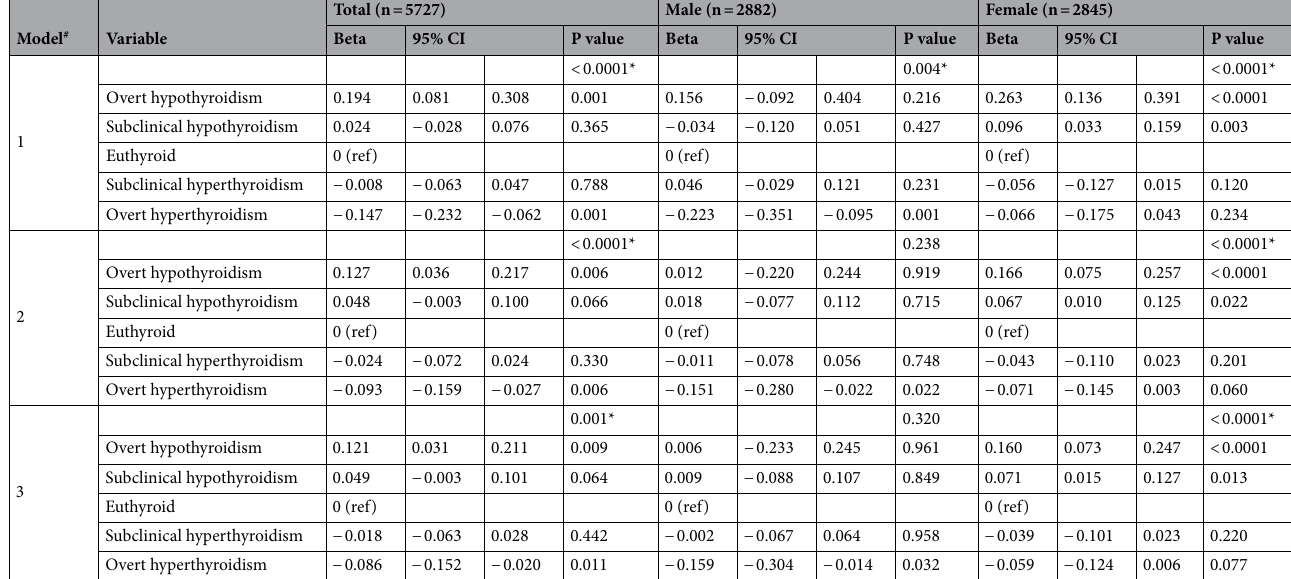
Table 3. Association between categorical thyroid function and TyG index. # Model 1: linear regression analysis, 2: multiple regression analysis after adjustment for age, sex, systolic blood pressure, BMI, alcohol consumption, 3: multiple regression analysis after adjustment for age, sex, systolic blood pressure, waist circumference, alcohol consumption * P -values < 0.05 were considered as statistically significant.